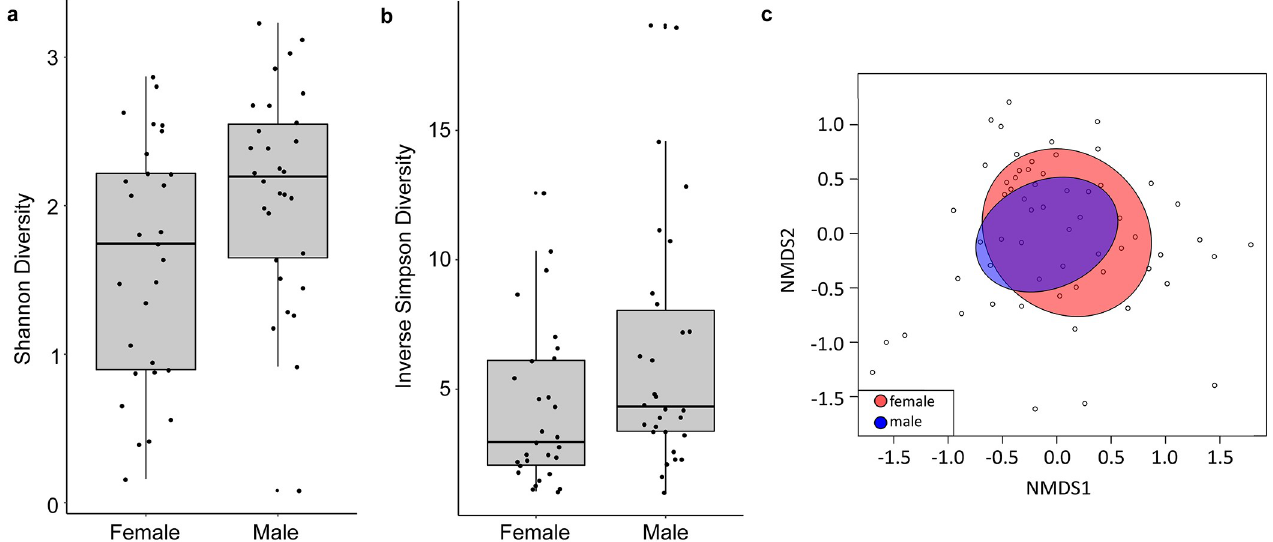
Fig 4. Comparison of the gut microbiome in male and female grasshoppers. Shannon diversity (a) and inverse Simpson diversity (b) indices for each female or male individuals were calculated with the vegan package in R. Nonmetric multidimensional scaling with dispersion ellipses placed for male and female pooled species (c) was plotted with the vegan package in R. NMDS was constructed using Bray-Curtis dissimilarity. Analysis of Similarity (ANOSIM) was performed and did not show a significant difference in the characteristic gut microbiota of males and females (R = 0.004, p = 0.352).